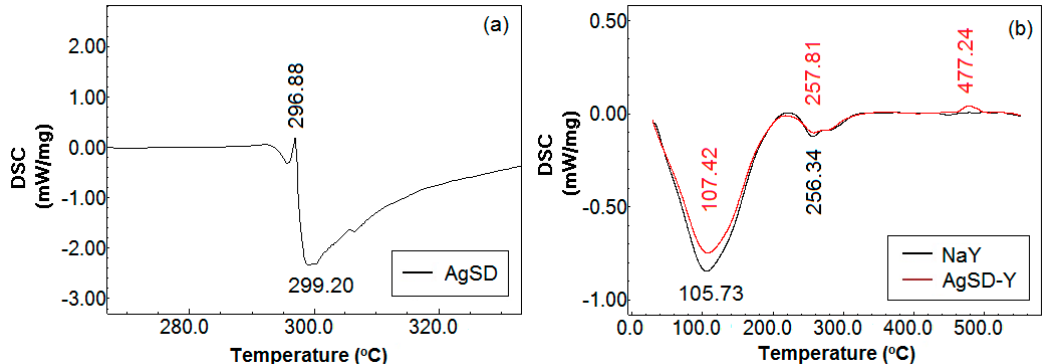
Figure 4. Heating curve of differential scanning calorimetry (DSC) of ( a ) pure AgSD and ( b ) NaY and AgSD-Y zeolite.